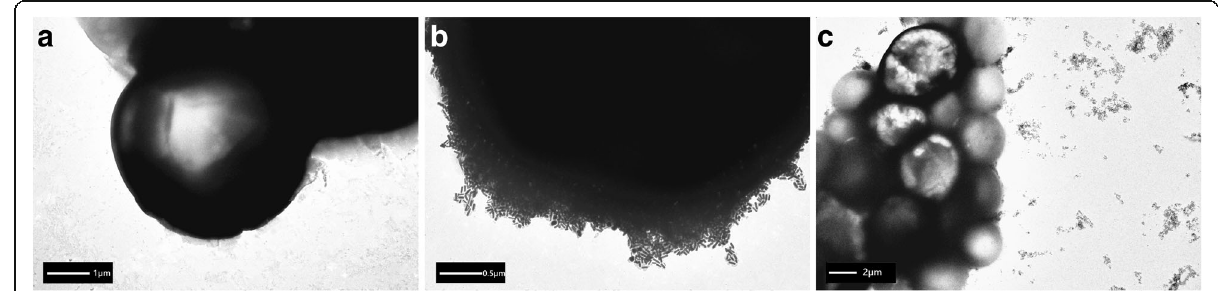
Fig. 5 TEM images illustrate the interaction between GNR-SiO 2 -Ab and C. neoformans cells. a TEM image of C. neoformans cells. b TEM image of